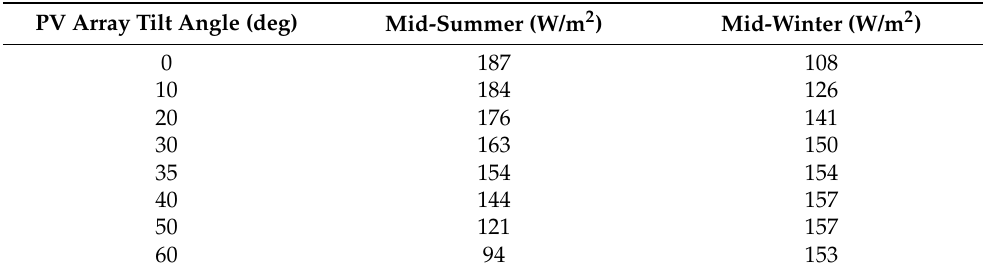
Table 3. PV panel maximum power yield per unit as a function of the tilt angle comparing mid- summer and mid-winter